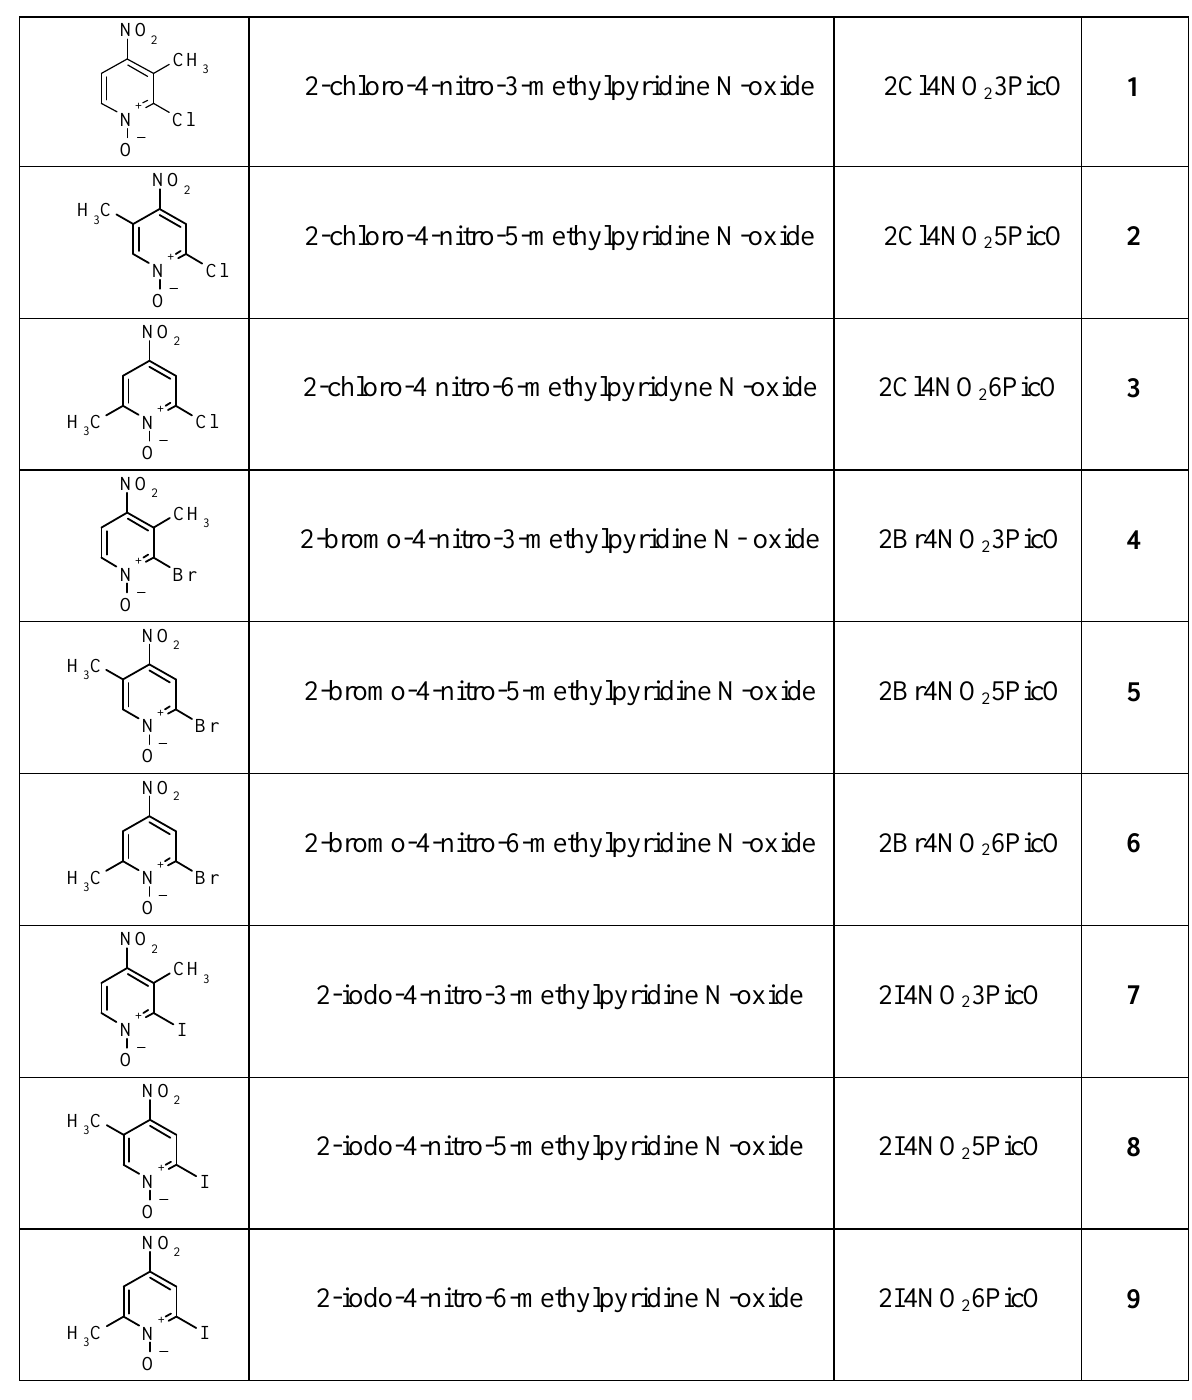
Table 1. Structures, full names, abbreviations and numbers used in text for 2-halo-4-nitropicoline N-